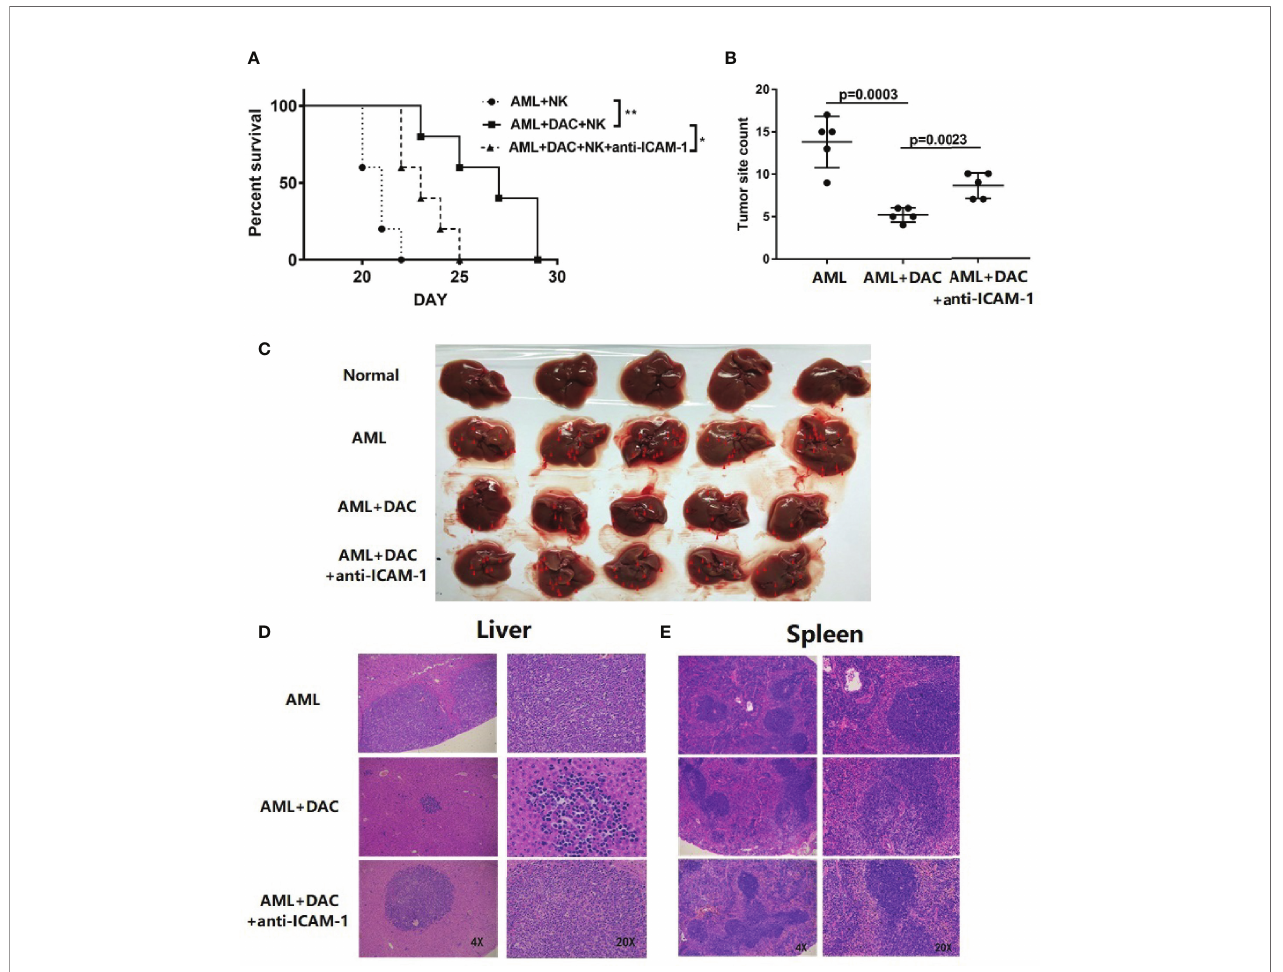
FIGURE 3 | ICAM-1 inhibits AML immune escape in vivo . (A) Survival of BALB/c mice injected with WEHI-3 cells supplemented or not supplemented with ICAM-1 antibody on Day 1, and then injected decitabine from Day 1 to Day 3, fi nally injected with NK cells on Day 3 (n=5). (B, C) The tumor site and count of mouse livers on 17 days after injection (mean ± SD, n=5). H&E staining of (D) livers and (E) spleen. *p < 0.05; **p <